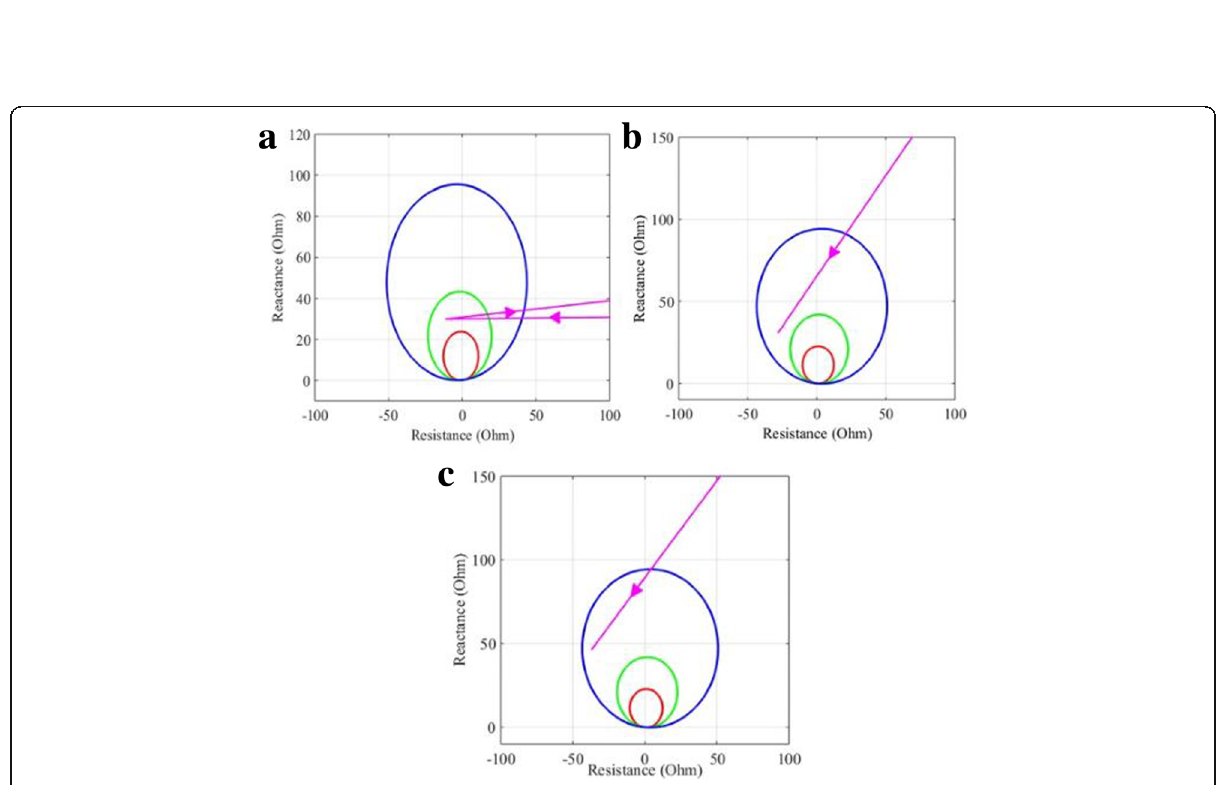
Fig. 6 Impedance trajectory of ( a ). R 6-11 , when power swing occurred due to loss of line 10-11; ( b ). R 4-3 , when load encroachment occurred due to overloading at BUS-3; ( c ). R 6-12 , when unbalanced loading occurred at